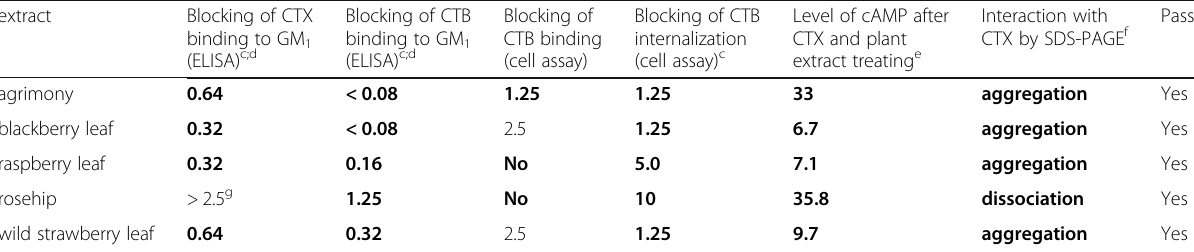
Table 5 Summary of beneficial plant extract effects a, b extract